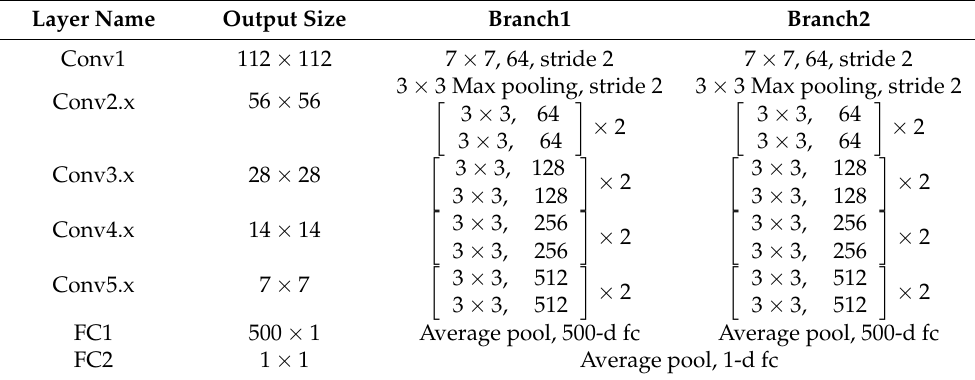
Table 1. Architecture parameters of the proposed transfer Siamese